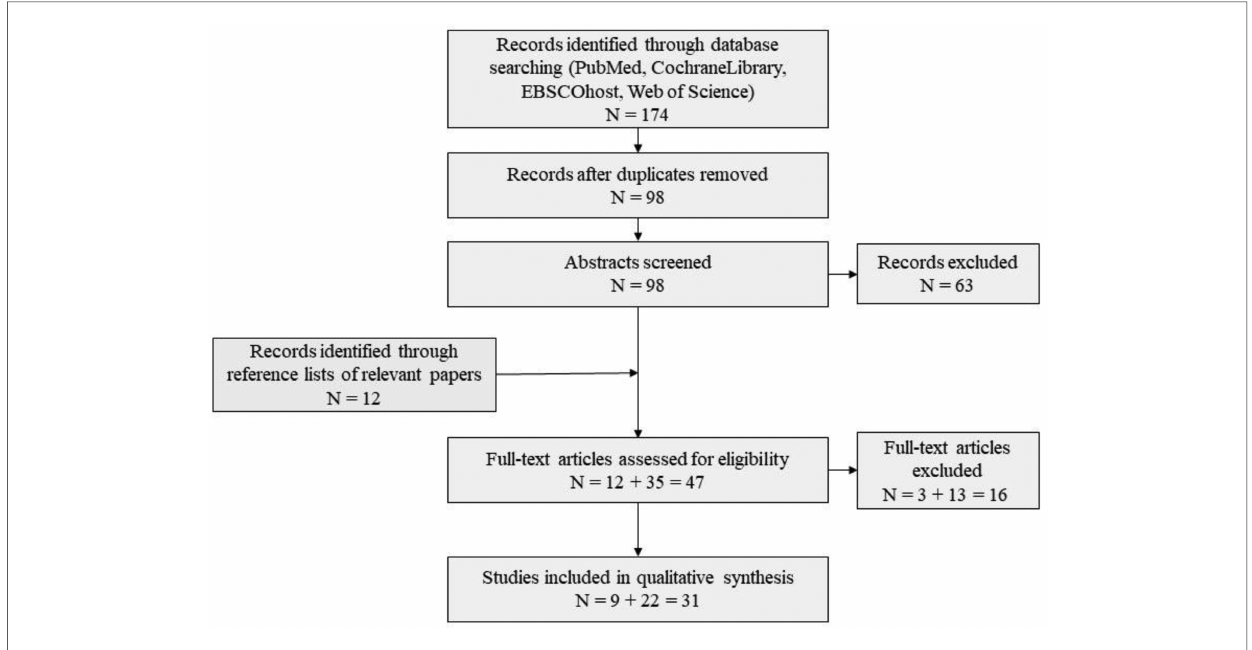
FIGURE 1 Flow chart of literature